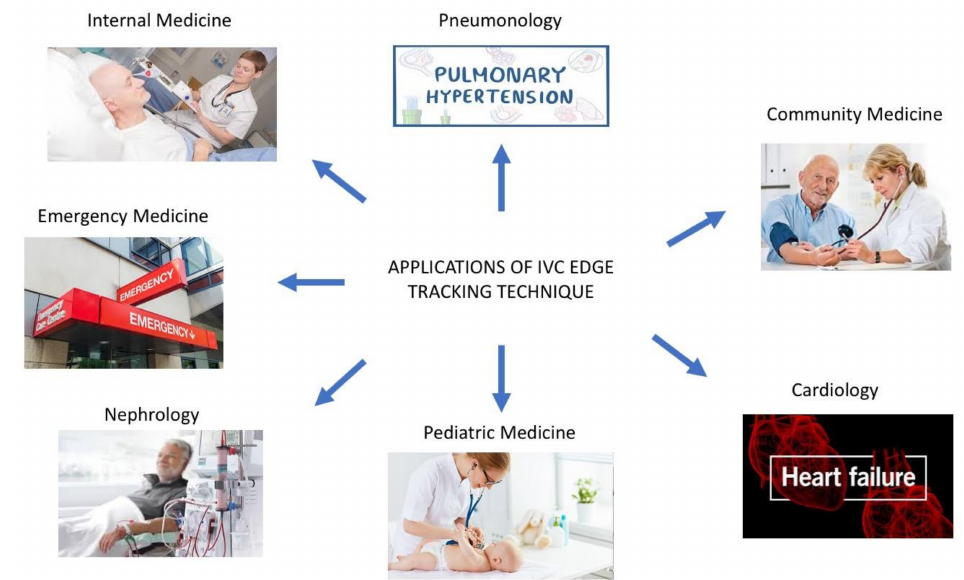
Figure 4. Our edge tracking technique could be applied in multiple clinical settings ( see the text for further explanations